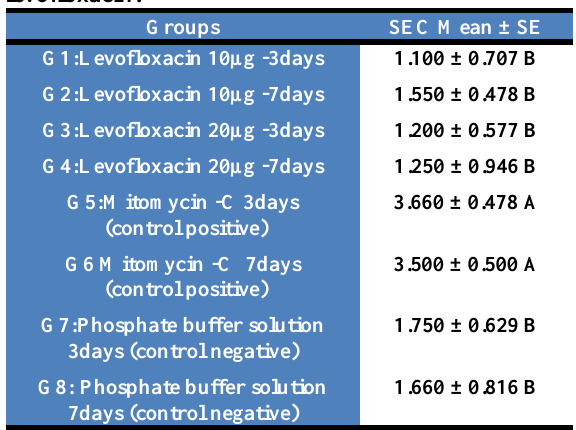
Table, 4: Hatchability index of chick embryos exposed to